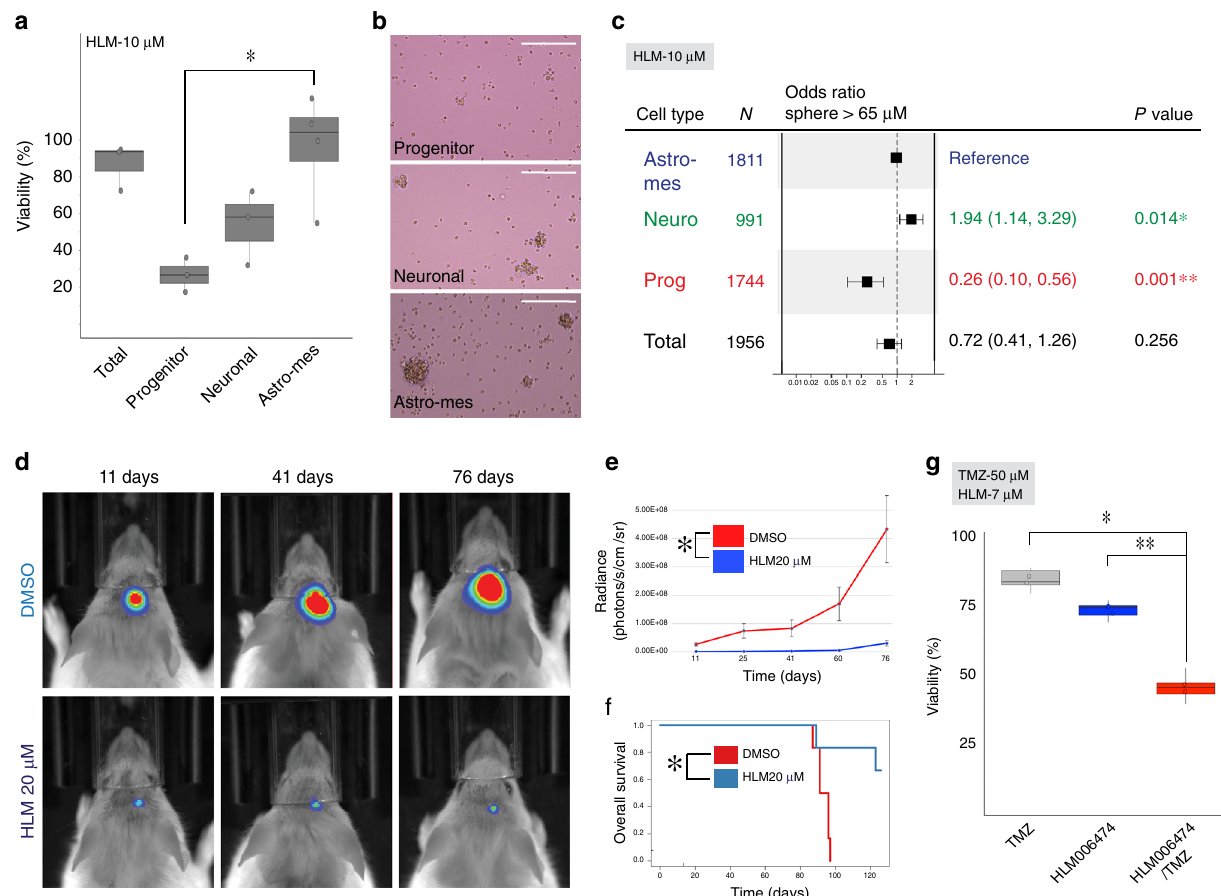
Fig. 7 Pathways enriched in progenitor cancer cells expose therapeutic opportunities. a Bar-graph showing the proportion of viable glioma stem cells (GSCs, BT333-GSC) sorted by type followed by 7 days of HLM006474 treatment, with each cluster normalized to corresponding vehicle control. Each bar in the graph represents the average of n = 3 biological replicates treated with HLM006474 as a ratio of the average of n = 3 DMSO-treated biological replicates. Data represented as mean±SE. A one-tailed, two-sample equal variance t test was used. b Representative images of GSCs at ×10 magni fi cation (bright fi eld), sorted by type and treated in HLM006474 for 7 days (images correspond to 7a). n = 2 biologically independent sphere forming experiments were performed. Scale bar: 400 μ M . c Forest plot showing the odds ratio of forming a tumor sphere >65 mm following 7 days of HLM006474 treatment, calculated using a multivariate logistic regression with the astrocytic GSC type as a reference, controlled for patient cell line. There was no signi fi cant difference between the two GSC lines ( p > 0.2), odds ratio with 95% con fi dence intervals are shown. d Bioluminescence images and e signals from representative mice treated with 20 m M HLM006474 vs DMSO with corresponding f Kaplan − Meier survival plot ( n = 16, eight per group). Data are represented as mean±SE. g Box − whisker plot showing the proportion of viable unsorted GSCs (BT326-GSC) after one of the following treatments: 6 days of TMZ treatment, 6 days of HLM006474 treatment, or 3 days of HLM006474 treatment followed by 3 days of TMZ treatment, normalized to corresponding vehicle control. n = 2 biological replicates per treatment. Box plot represents the fi rst quartile, median, and third quartile with whiskers extending to 1.5 times the interquartile range. The overlaid fi lled dot-plots represent the mean value per biological replicate per group. P values: TMZ/HLM, 0.004; HLM/combination, 0.01. For all plots, ** p < 0.01, * p <